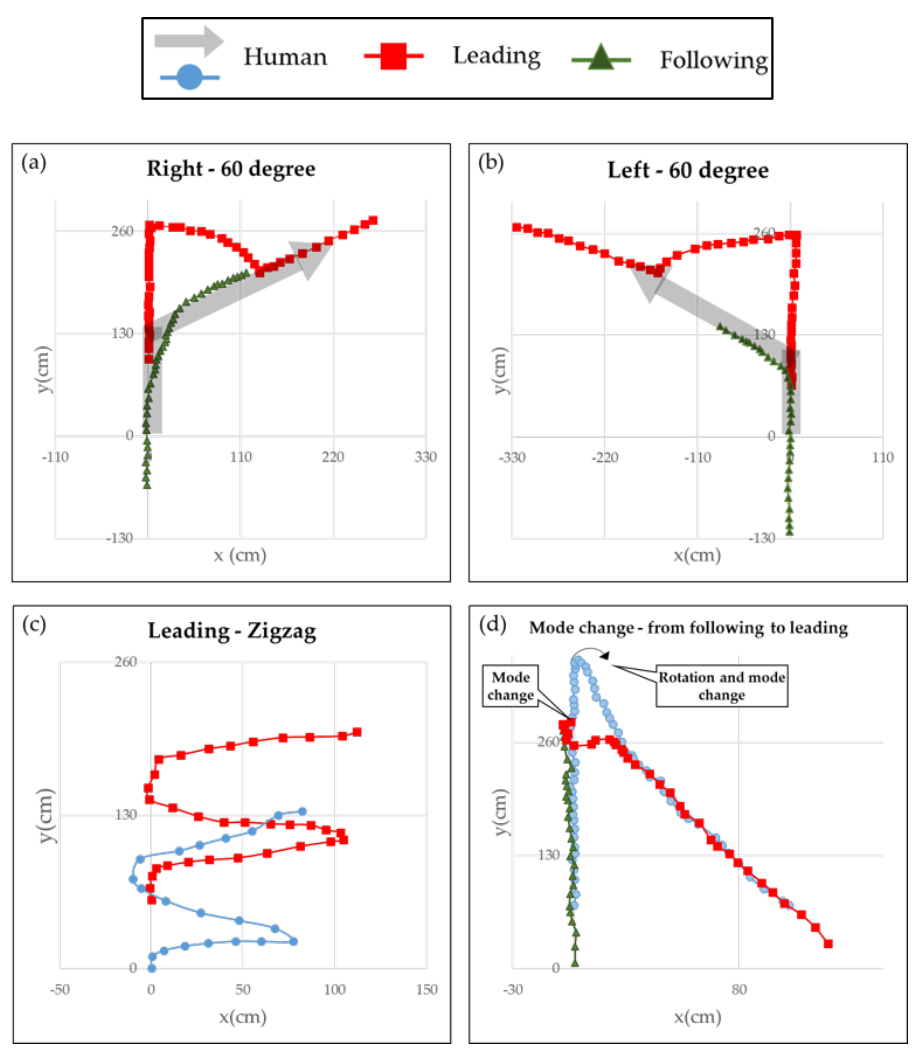
Figure 18. Results of the trajectory test: ( a ) turning right at 60 ° ; ( b ) turning left at 60 ° ; ( c ) zigzag; and ( d ) mode change.